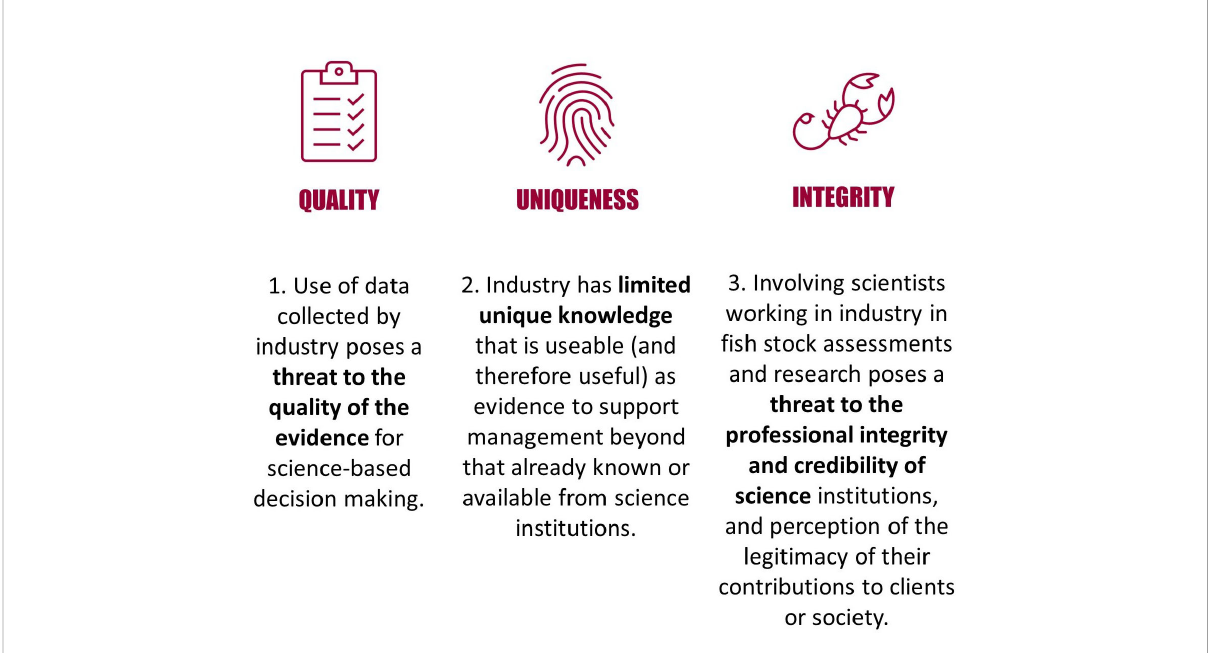
FIGURE 1 Analytical framework: Three key issues and associated provocative